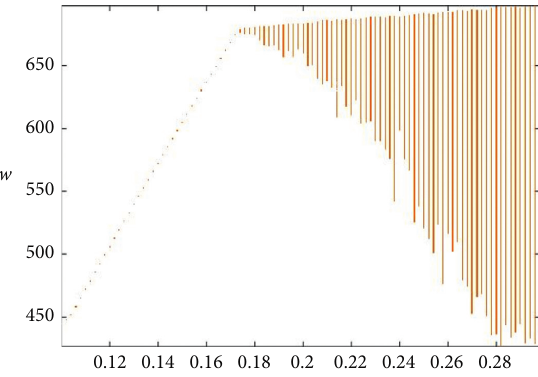
Figure 13: Bifurcation diagram generated by the Poincar _ e section of system (10), where α � 0 . 1 ∼ 0 . 3, β � 0 . 5 ,k � 0 . 75 ,b � 50 ,b � � 0 . 01 ,C � 200 , and p � 0 . 450 , T 1